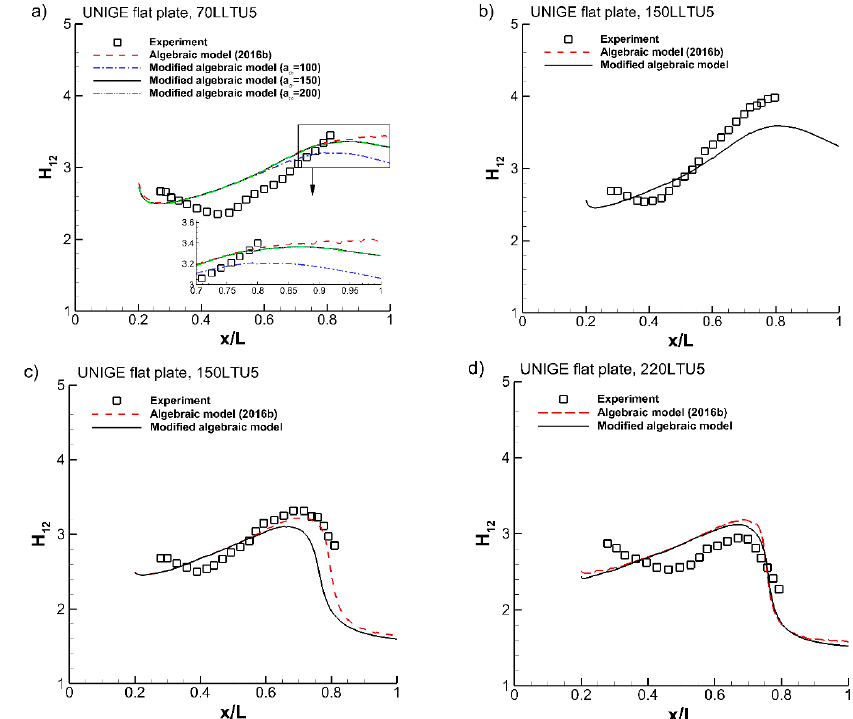
Figure 5. UNIGE flat plate. Measured and predicted shape factor evolutions for cases without transition before the end of the plate ( a , b ) and with bypass transition ( c , d ).